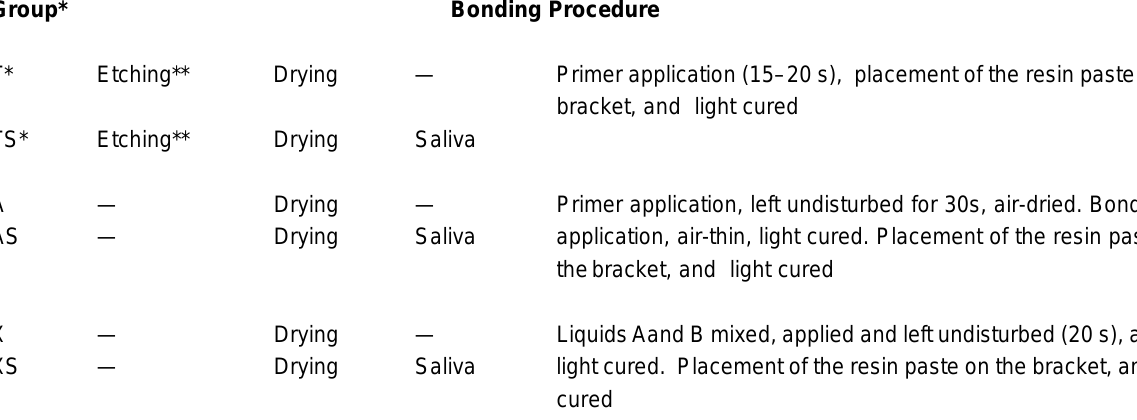
FIGURE 2- Bonding procedure according to adhesive system used. * T= Transbond XT; TS= Transbond with contamination; A= AdheSE; AS= AdheSE with contamination; X= Xeno III; XS= Xeno III with contamination.** 15-s 37% phosphoric acid etching and 15-s rinsing TABLE 1- Shear bond strength means (in MPa) and standard deviation